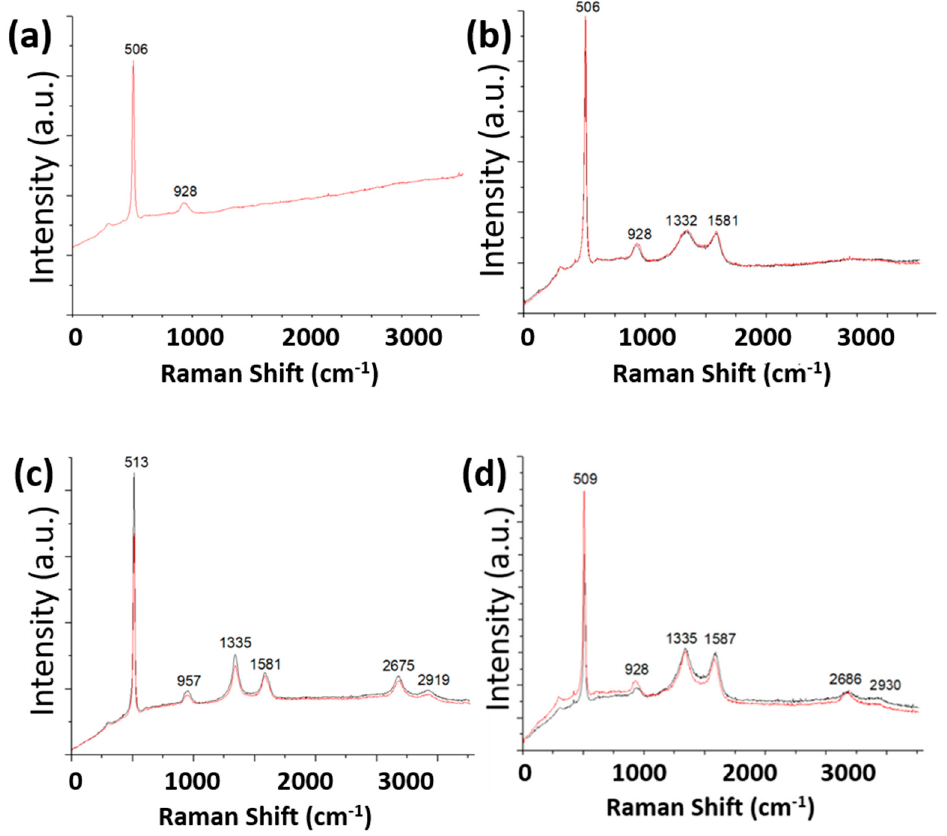
Figure 7. Raman spectra excited by 532 nm laser measured from ( a ) silicon flakes, ( b ) silicon flakes with an RF carbon coating, ( c ) silicon flakes with SiC coatings, and ( d ) silicon flakes with combined SiC and RF carbon coatings.